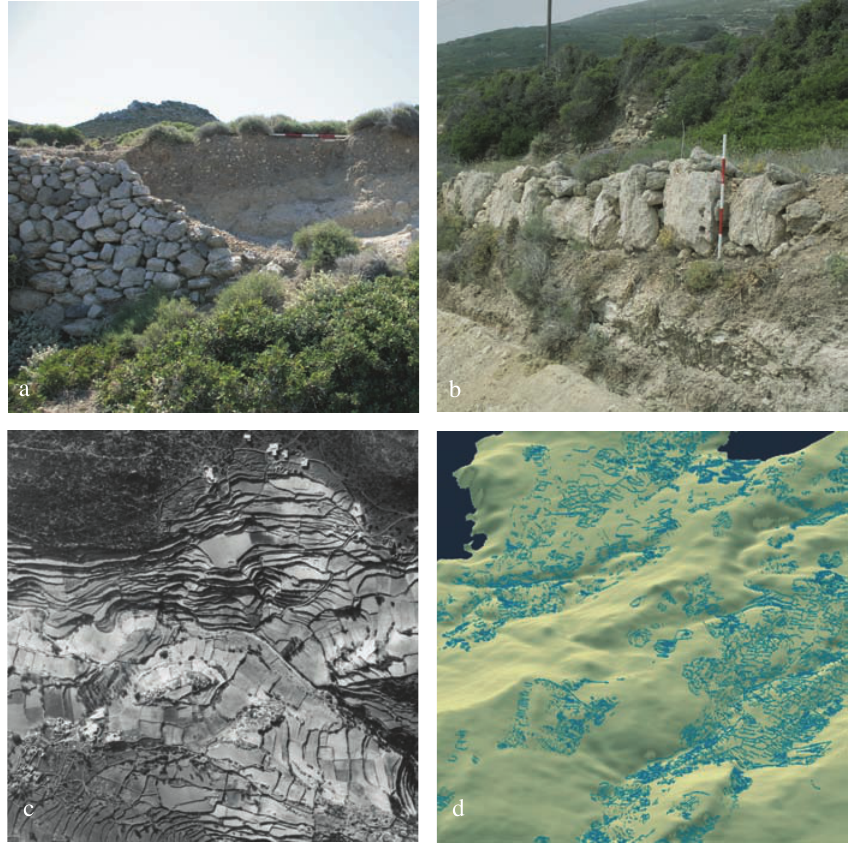
Figure 7 Terracing on Antikythera: a) a collapsed terrace wall made of even-sized limestone cobbles with at least two buried soil horizons behind it, b) a collapsing terrace wall made in a different technique, with large limestone slabs filled with smaller stones, c) an aerial photograph from 1944 when the terraces were last under heavy cultivation (courtesy of the Aerial Reconnaissance Archive), d) perspective view looking north-west with individual terraces plotted on top of a digital elevation